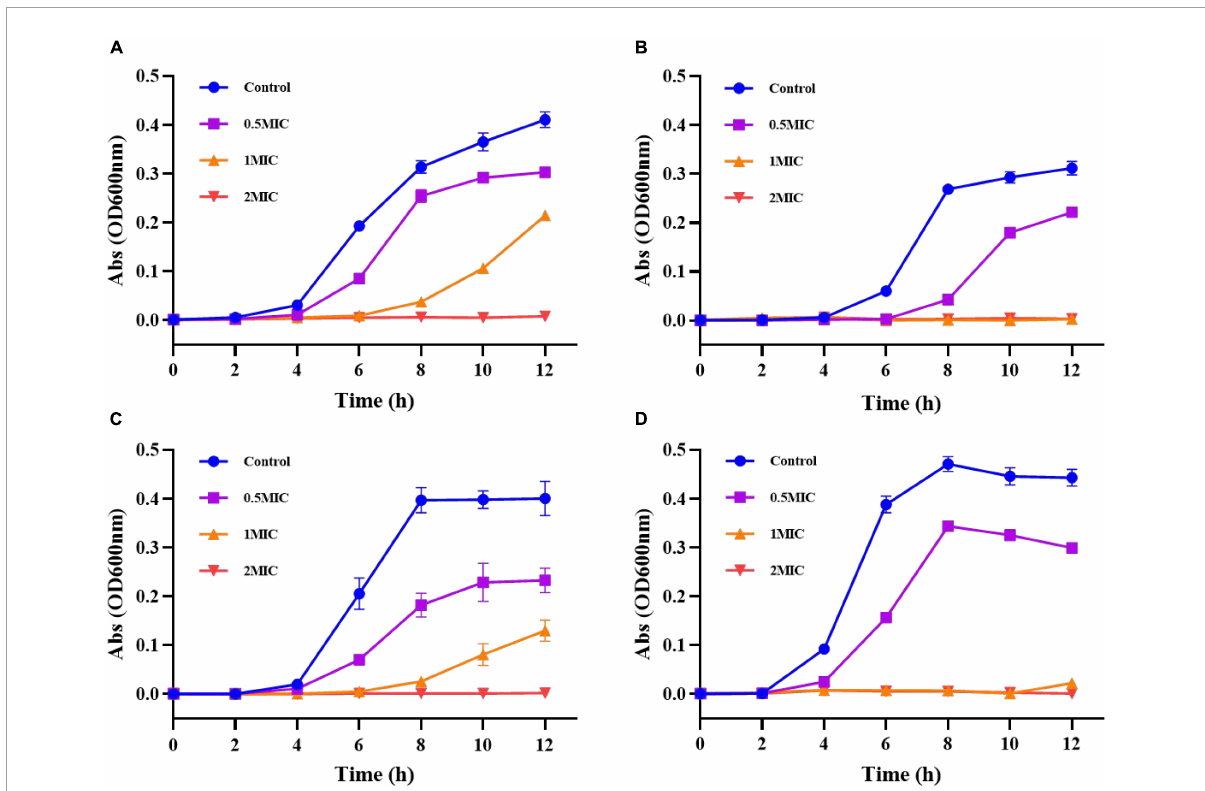
FIGURE10 Growth curves of Staphylococcus aureus (A) , Escherichia coli (B) , Salmonella typhimurium (C) , and Listeria monocytogenes (D) after treatment with different concentrations of